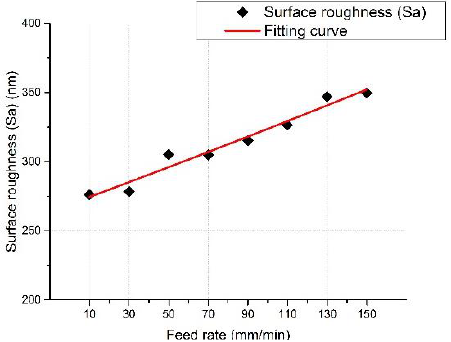
Figure 3. Influence of feed rate on surface roughness.